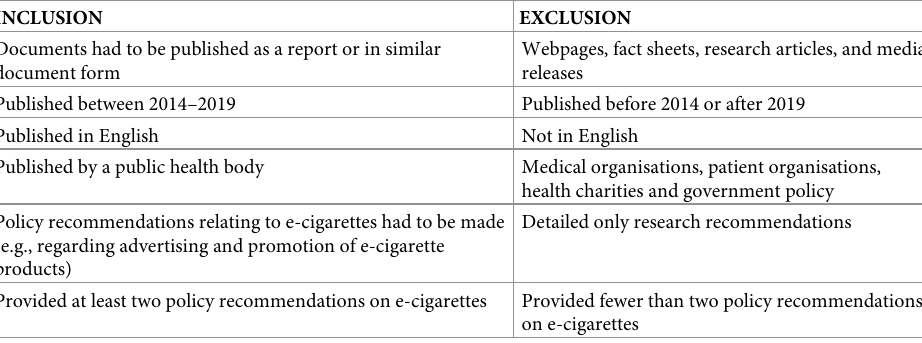
Table 1. Criteria for including documents in the